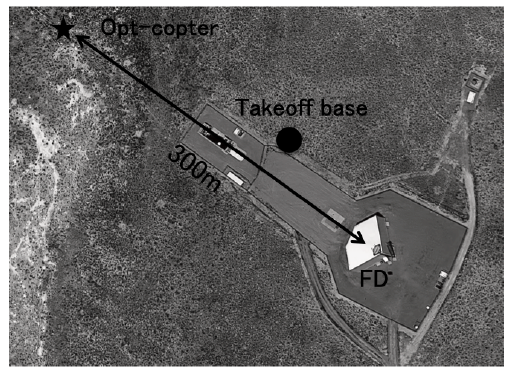
racy in advance. The light source is designed to be seen from the FD at the distance of 300 m, and the vehicle flies around in the field of view of the camera with a position- ing accuracy of 10 cm, which corresponds to a directional accuracy of 0 : 02 ◦ . Fig. 10 shows a bird’s eye view of an Opt-copter flight.